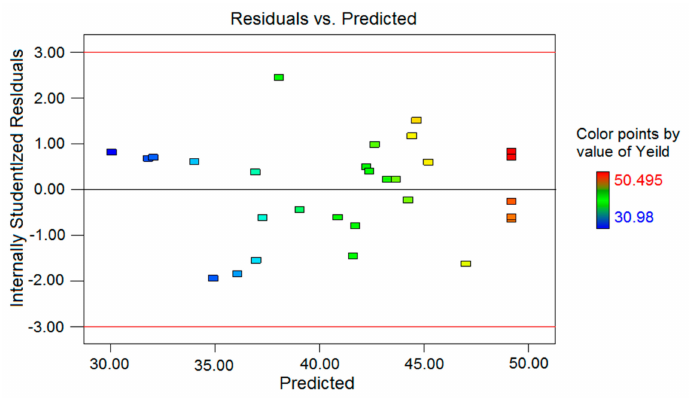
Figure 2. The studentized residuals and predicted response